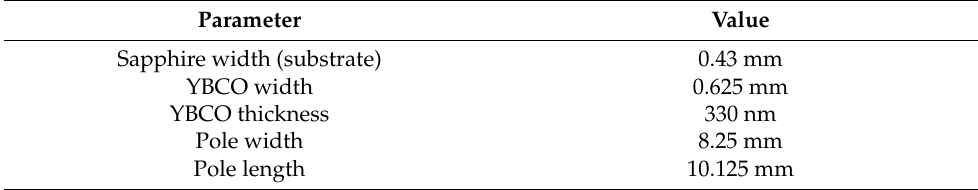
Table 1. Geometric dimensions of the HTSC filter.